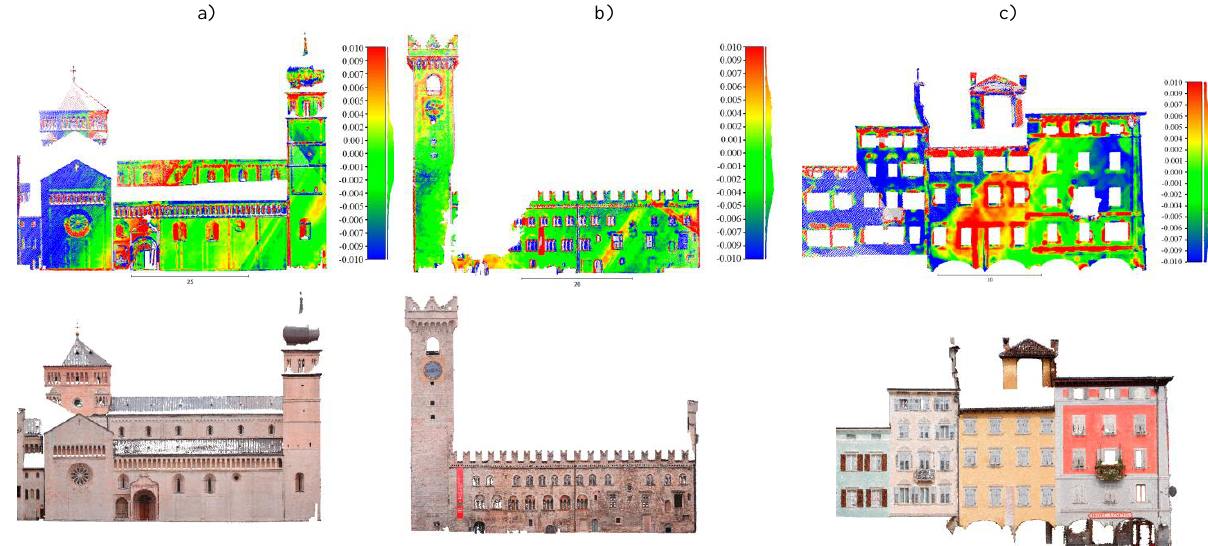
Figure 10. Colour-coded maps of the comparison analysis between the MMS and Photogrammetry data for the Cathedral (a), Palace (b) and Hotel (c) datasets. The scale ranges from - 0.01 m (blue) to 0.01 m (red). Corresponding photogrammetric point clouds are shown below. Raw comparison